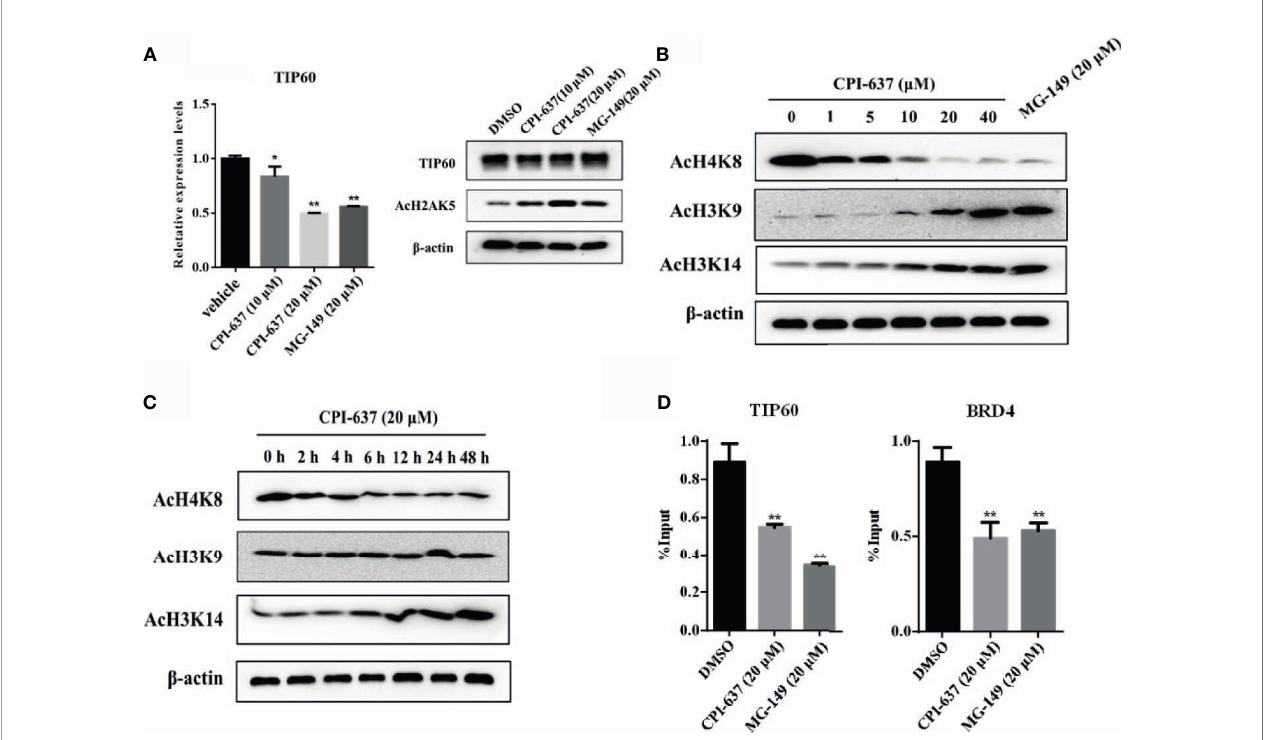
FIGURE 5 | CPI-637 activates HIV-1 latency via a TIP60-mediated signaling pathway. The effect of CPI-637 at the indicated concentrations on the expression of TIP60 mRNA and AcH2AK5 level were determined by RT-qPCR and WB respectively (A) . ACH2 cells were treated with CPI-637 for 48 h at the indicated concentrations (B) or with CPI-637 (20 m M) at the indicated time points (C) , and then the levels of AcH4K8, AcH3K9 and AcH3K14 were analyzed by WB. After treatment with CPI-637 (20 m M) for 48 h, the occupancy of BRD4 and TIP60 at the HIV-1 LTR promoter in ACH2 cells was detected by ChIP-qPCR assays (D) . (* p < 0.05 vs DMSO control group, ** p < 0.01 vs DMSO control